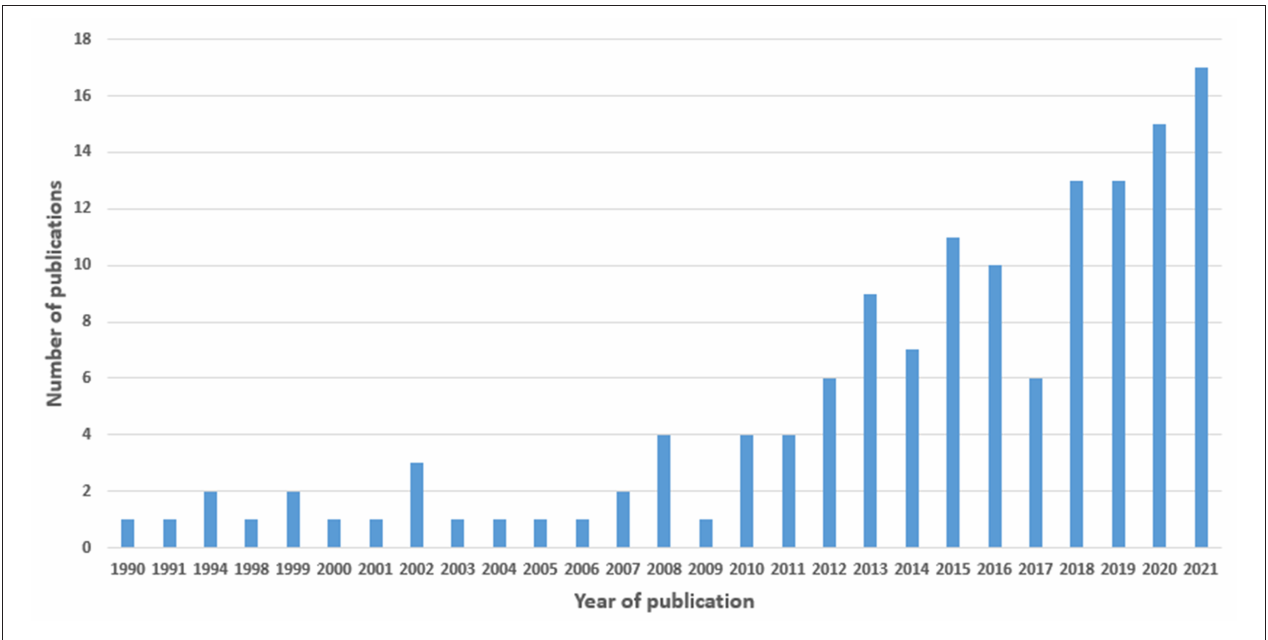
FIGURE 3 | Trend in the number of included studies over time in years, 1990 to